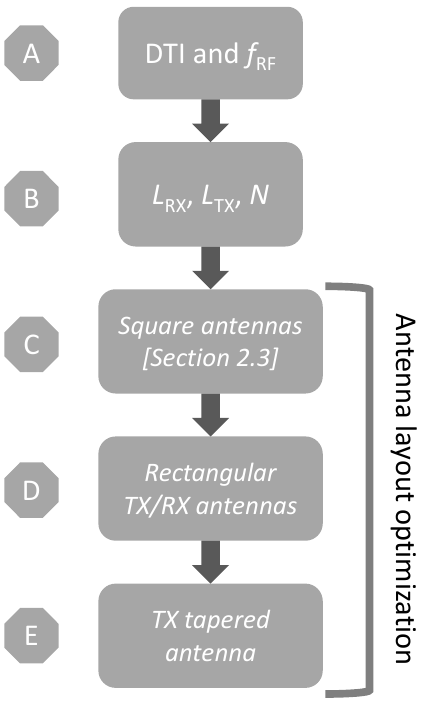
Figure 13. Simplified block diagram of the proposed design flow.